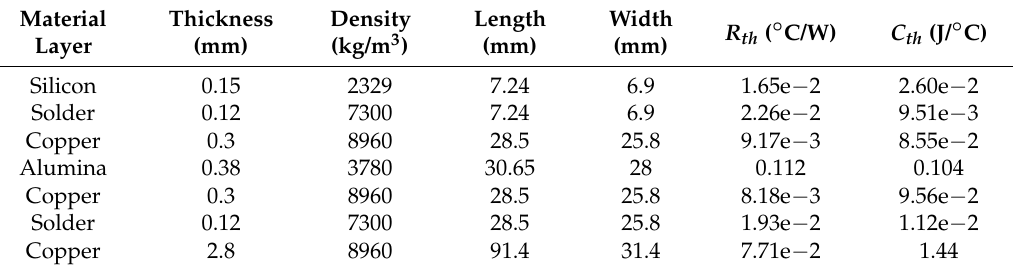
Table 2. Parameters of the IGBT module (SKM75GM12T4).